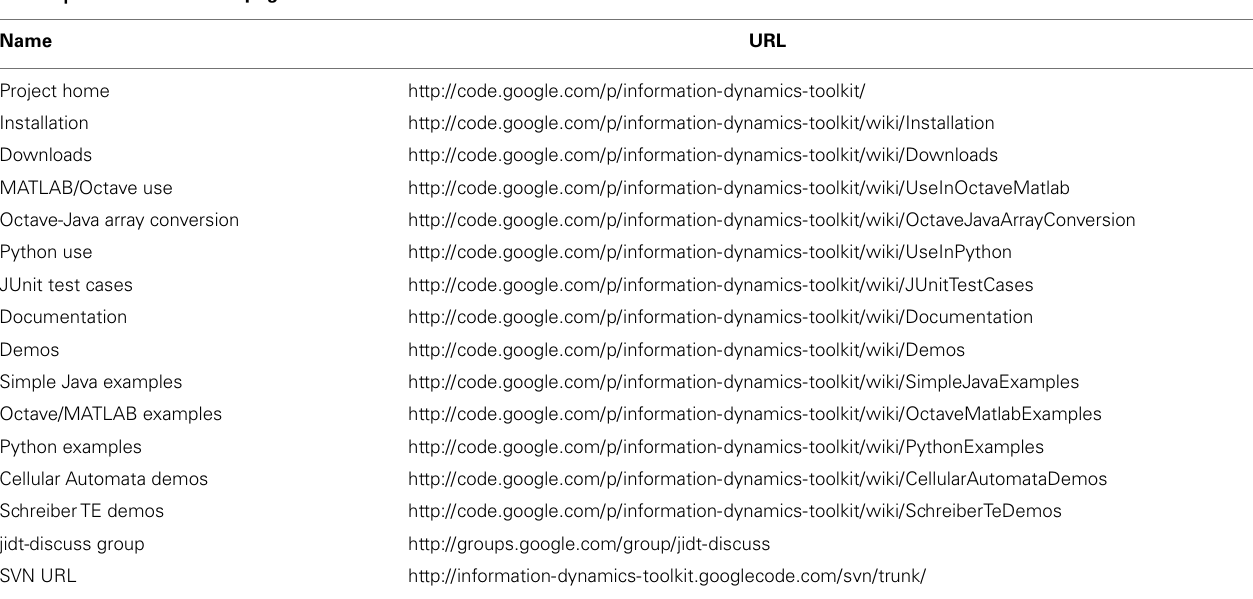
Table 2 | Relevant web/wiki pages on JIDT website